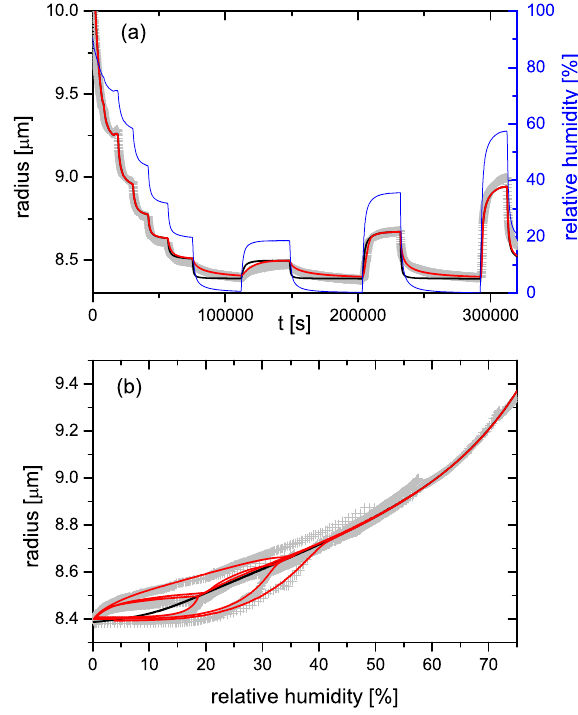
Figure 8. (a) Data of Fig. 2 converted to radius vs. time (gray crosses), equilibrium prediction of radius using the activity parametrization of Sect. 3.3 (black line), diffusion model with a dif- ) = − 8 . 7 − 7 . 5 ( 1 − a w ) using the same activity fusivity of log (D H 2 O parametrization (red line). Relative humidity (blue line) right axis. (b) The same data plotted vs. relative humidity. At RH > 40% at 293.5K we observe no kinetic limitations to water uptake or re- lease, while below that humidity kinetic limitations become clearly visible by the hysteresis loops in water uptake and